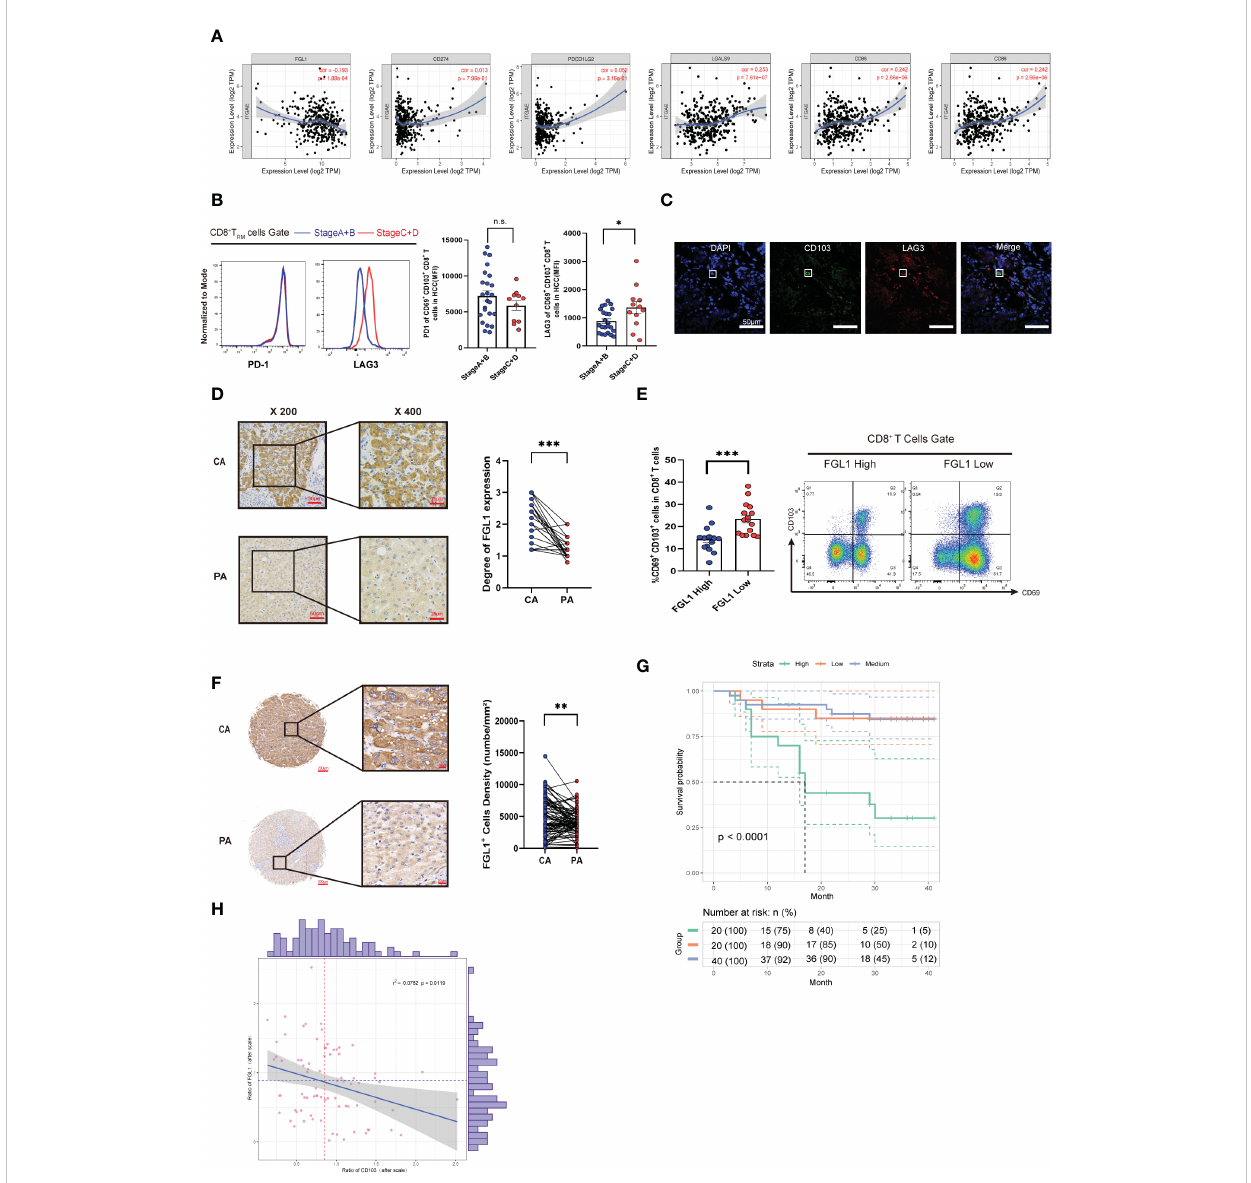
FIGURE 3 FGL1 expression is increased in HCC and correlates with poor prognosis. (A) Expression scatterplots of correlations between the genes of CD103 and FGL1, MHC-II, LSECtin, galectin-3, PD-L1, and PD-L2 in HCC of the TIMER cohort. Spearman correlation coef fi cient test was calculated. (B) MFI of PD-1 and LAG3 expression by CD8 + T RM cells in the liver cancer tissues of Cohort 1 patients, which were grouped by the BCLC score (n = 35, Student ’ s t -test). (C) Representative confocal assay of CD103 with LAG3 (400×) in the liver tissues of HCC patients from Cohort 1 (n = 10). (D) Representative IHC staining of FGL1 (inverted microscope, 200×, 400×) in CA and PA of patients from Cohort 1 (n = 35, A paired t -test). (E) The frequency of CD103 + CD69 + CD8 + T cells in groups with high or low FGL1 expression in HCC patients from Cohort 1. The cutoff for FGL1-based grouping was determined by the median (n = 30, Student ’ s t -test). (F) Representative IHC staining of FGL1 (inverted microscope, 200×, 400×) in TMA. Quanti fi cation of FGL1 in the HCC patients from Cohort 2 (n = 80, Student ’ s t -test). (G) Kaplan – Meier curves for the overall survival of the groups with high, medium, and low FGL1 expression in Cohort 2, according to the tri-sectional quantiles, showed that the patients with high FGL1 expression had worse outcomes than those with low FGL1 expression (n = 80, P< 0.0001). (H) Correlation between CD103 + cell density and tumor volume (n = 80, Spearman r 2 = 0.0755, P = 0.007). (A – H) Bars represent mean ± SEM. BCLC, Barcelona Clinic Liver Cancer; CA, carcinoma tissue; FGL1, fi brinogen-like protein 1; HCC, hepatocellular carcinoma; IHC; immunohistochemistry; MFI, mean fl uorescence intensity; PA,